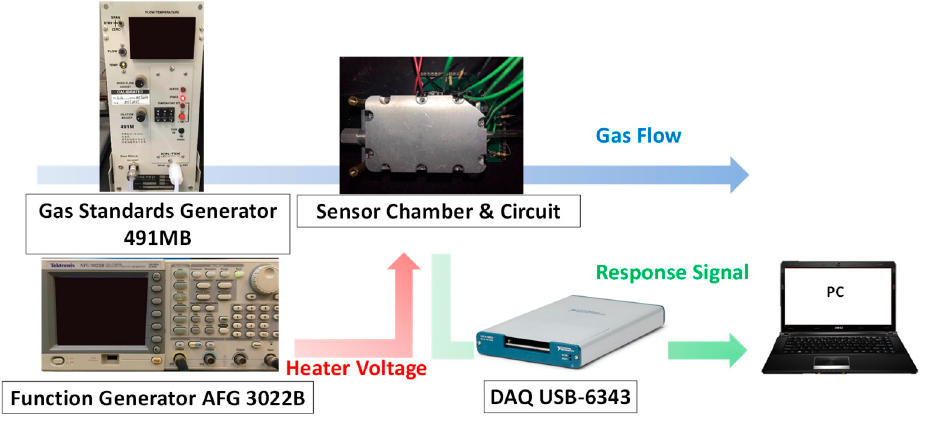
Figure 2. Experimental setup of the sensing system.